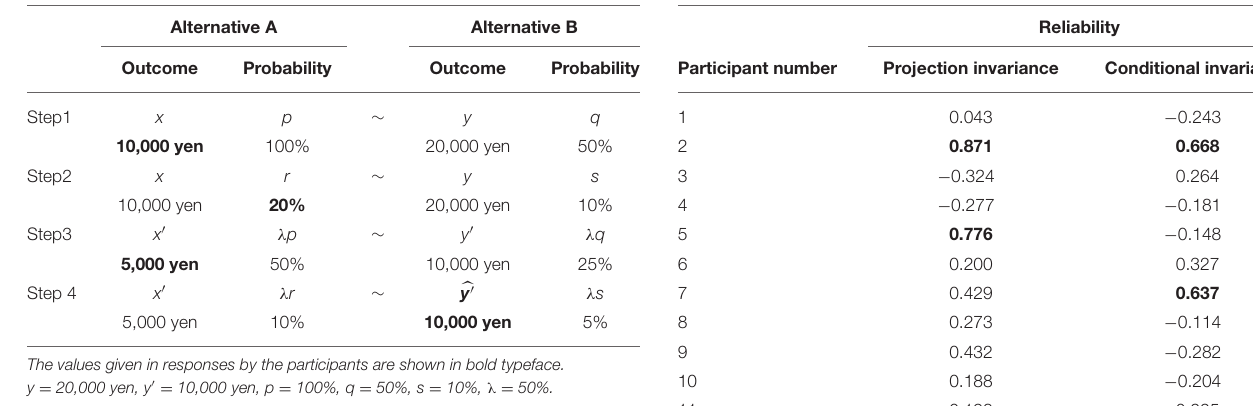
TABLE 3 | Verification process of conditional invariance. TABLE 5 | Reliability of projection invariance and conditional invariance (final